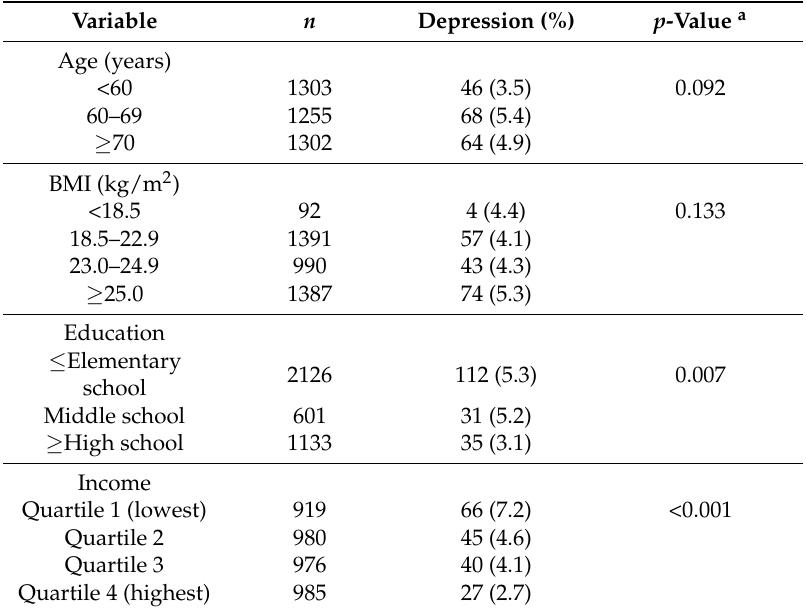
Table 1. Prevalence of depression in postmenopausal women according to demographic characteristics. Variable n Depression (%) p -Value